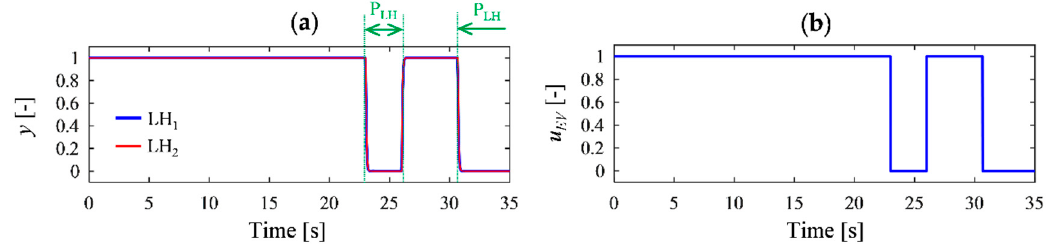
Figure 12. ( a ) Simulated poppet lift of the vented load-holding valves; ( b ) Electro-valve command.